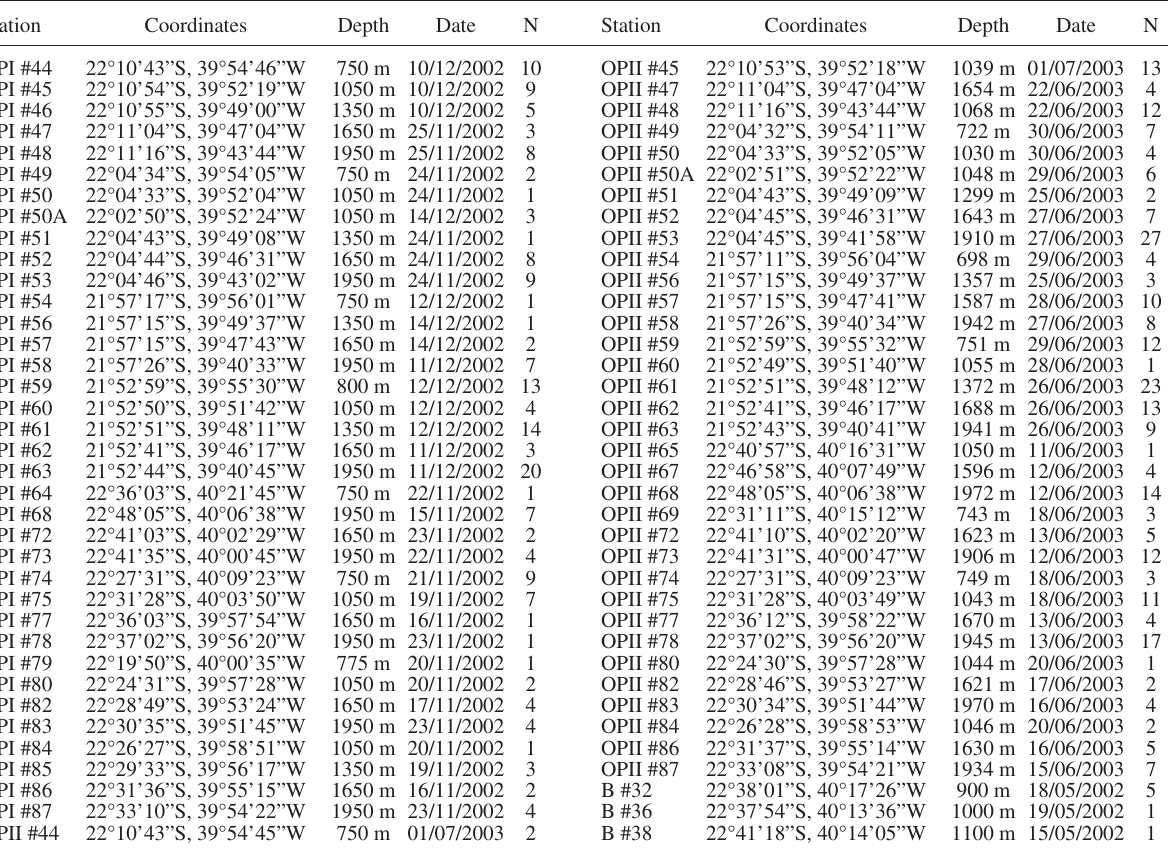
Table 1. – Geographical data for stations sampled with a box-corer. Number of specimens (N) refers to those belonging to the studied